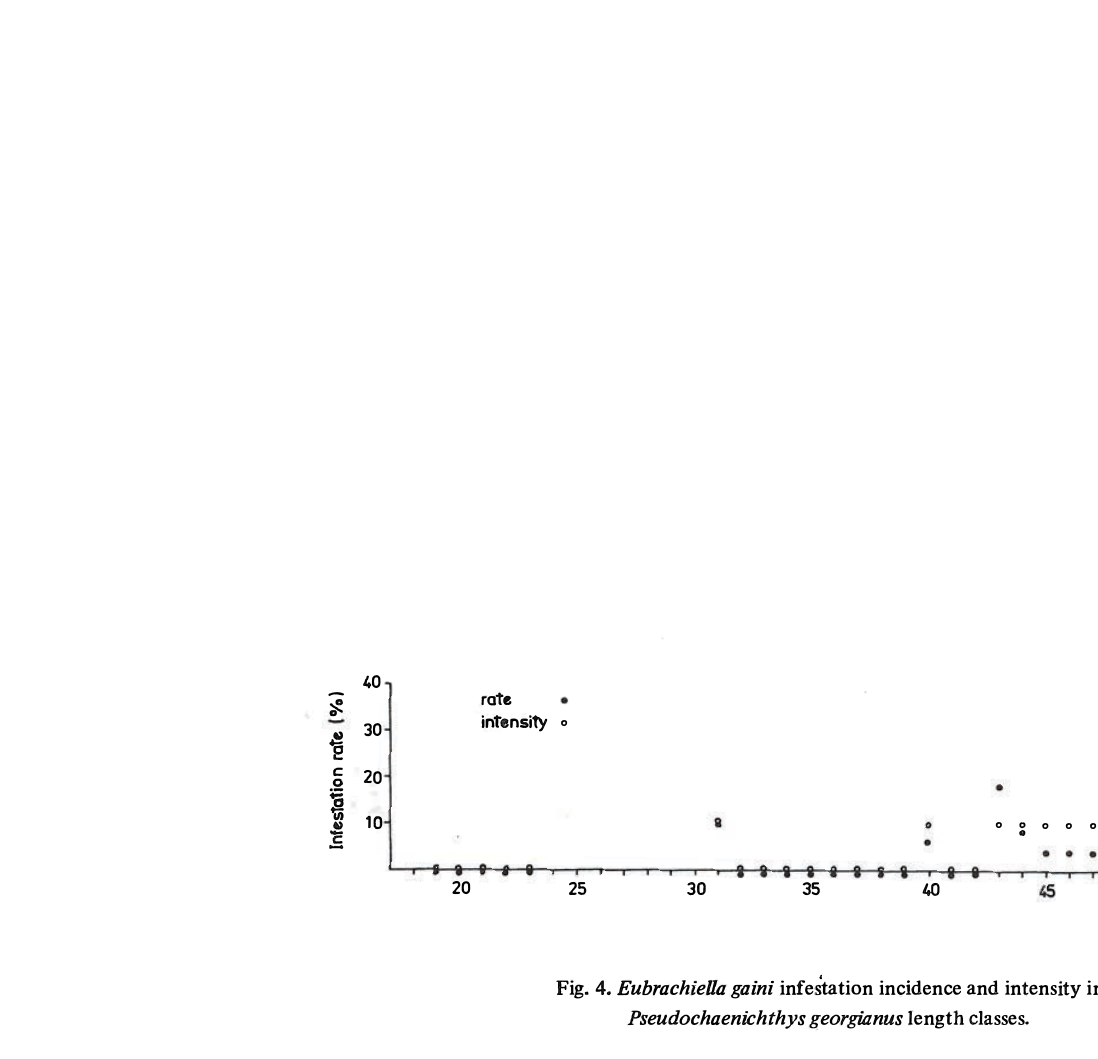
Fig. 4. Eubrachiella gaini infe;tation incidence and intensity in Pseudochaenichthys georgianus length